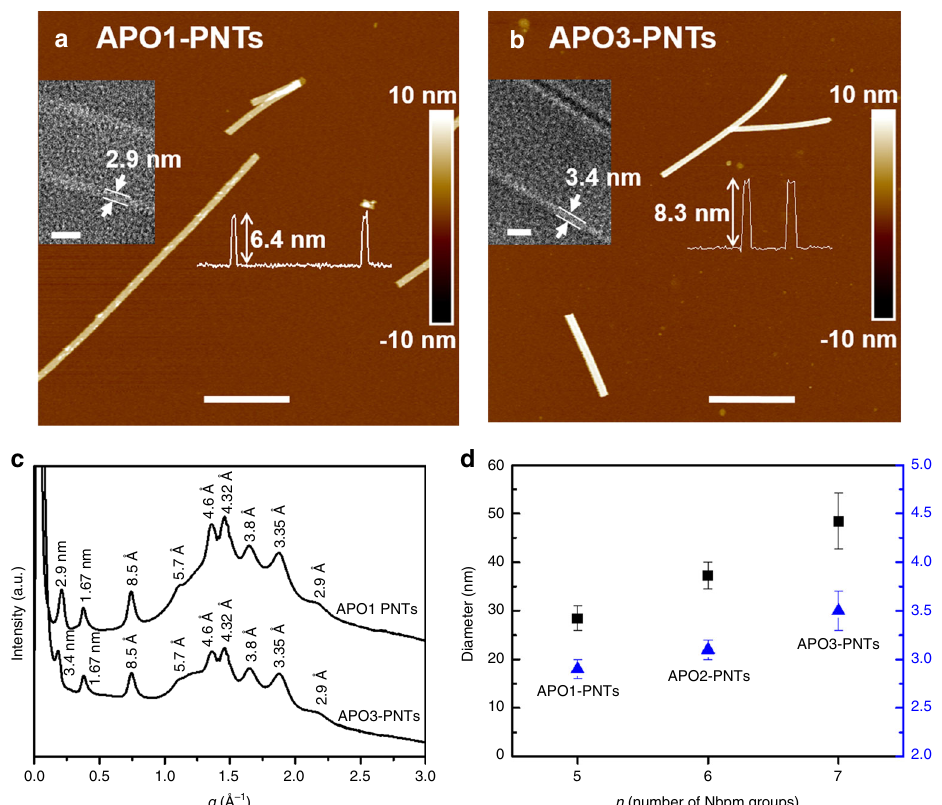
Fig. 3 Tunability of PNT wall thickness and diameter. a AFM height image of APO1-PNT (scale bar, 500 nm); the left inset is the high-resolution TEM image of one APO1-PNT showing the PNT wall thickness (scale bar, 10 nm) and the right inset is the AFM height measurement showing the PNT height. b AFM height image of APO3-PNT (scale bar, 800 nm); the left inset is the high-resolution TEM image of one APO3-PNT showing the PNT wall thickness (scale bar, 10 nm) and the right inset is the AFM height measurement showing the PNT height. c XRD spectra of APO1-PNTs and APO3-PNTs, showing both APO1-PNT and APO3-PNT have similar structures. d PNTs wall thickness and diameter tuned by varying the number ( n ) of Nbpm side chains of APOs; Each value represents the mean standard deviation obtained from measuring at least 50